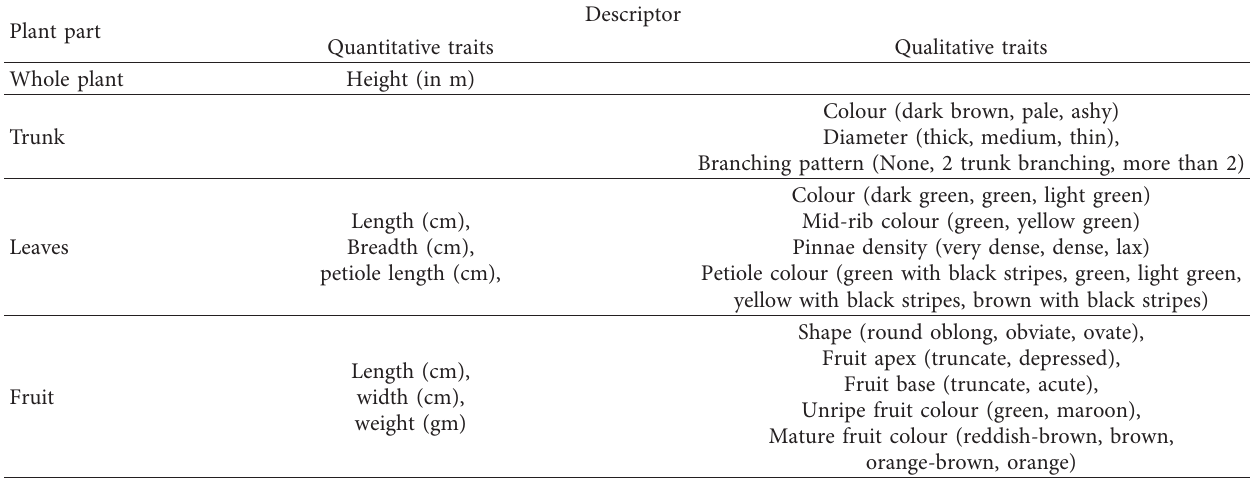
Table 2: Quantitative and qualitative descriptors used for the morphological characterization of doum palm. Plant part